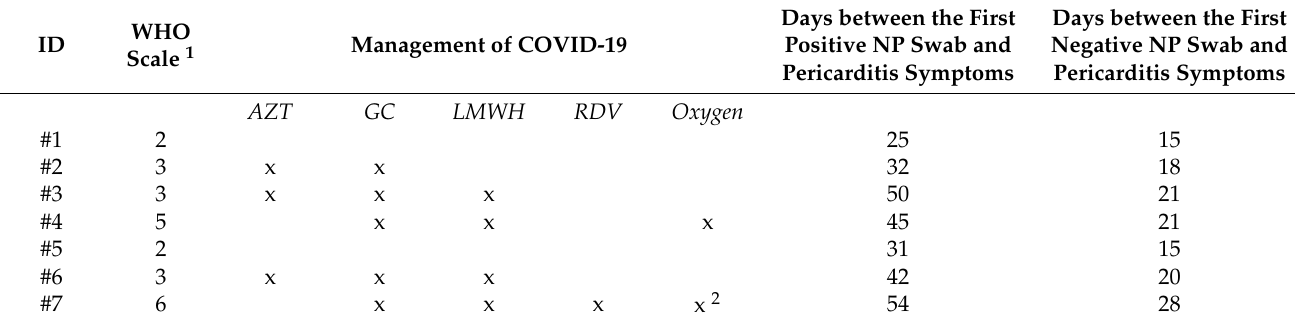
Table 2. Characteristics and management of SARS-CoV-2 infection and timing of pericarditis symptom occurrence.